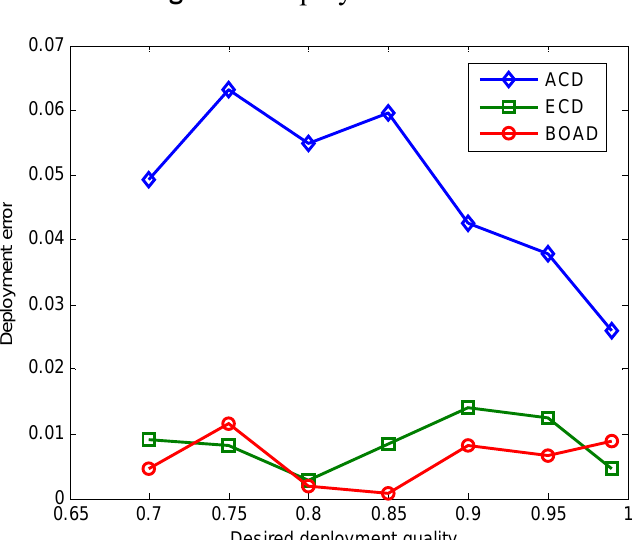
Figure 5. Deployment